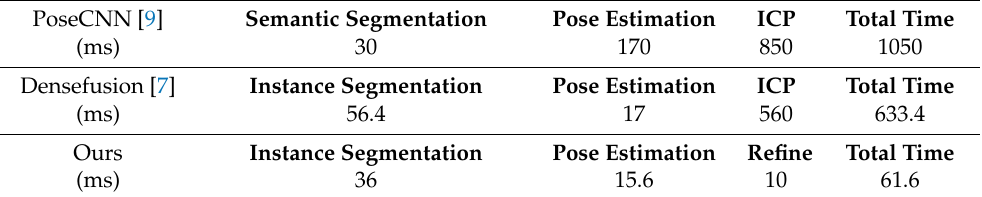
Table 2. Average running time of three 6D pose estimation